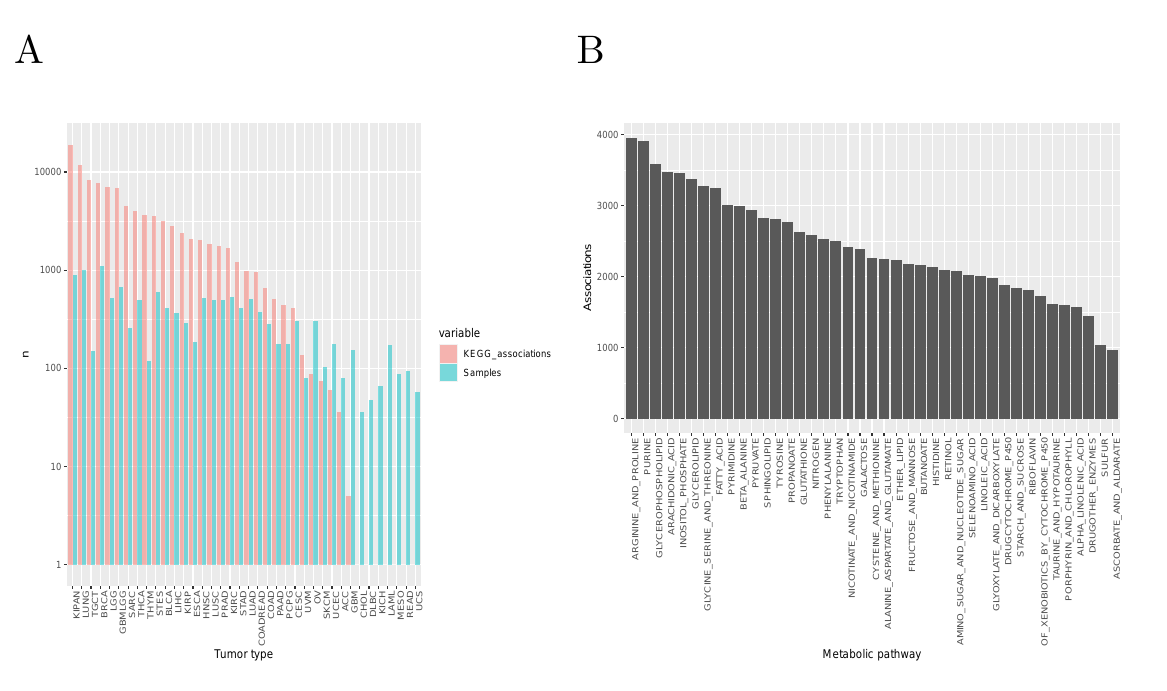
Figure 3. ( A ) Number of samples and of significant associations with molecular and clinical features by tumor type. ( B ) Number of significant associations by KEGG metabolic